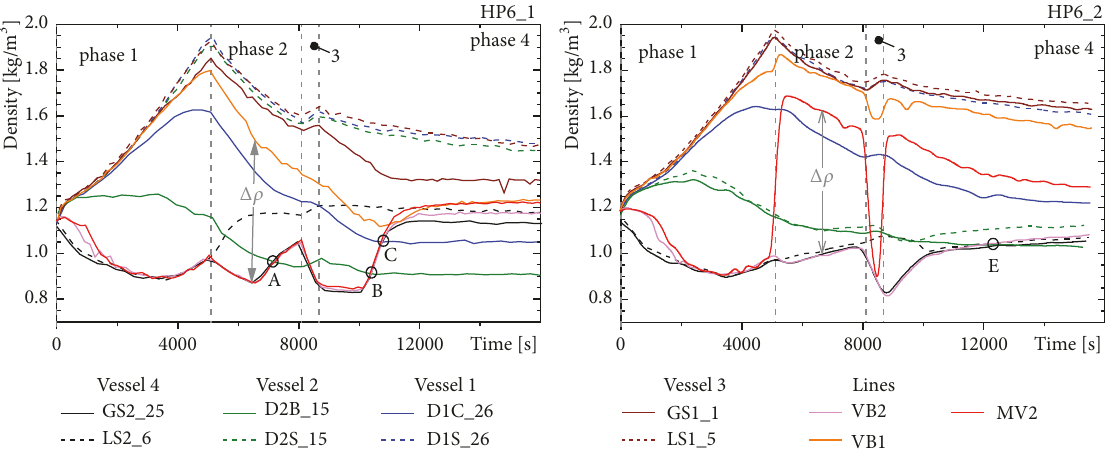
Figure 5: Density as a function of time for selected locations in all for vessels for experiments HP6 1 (left) and HP6 2 (right). Legend nomenclature refers to locations depicted in Figure 3.